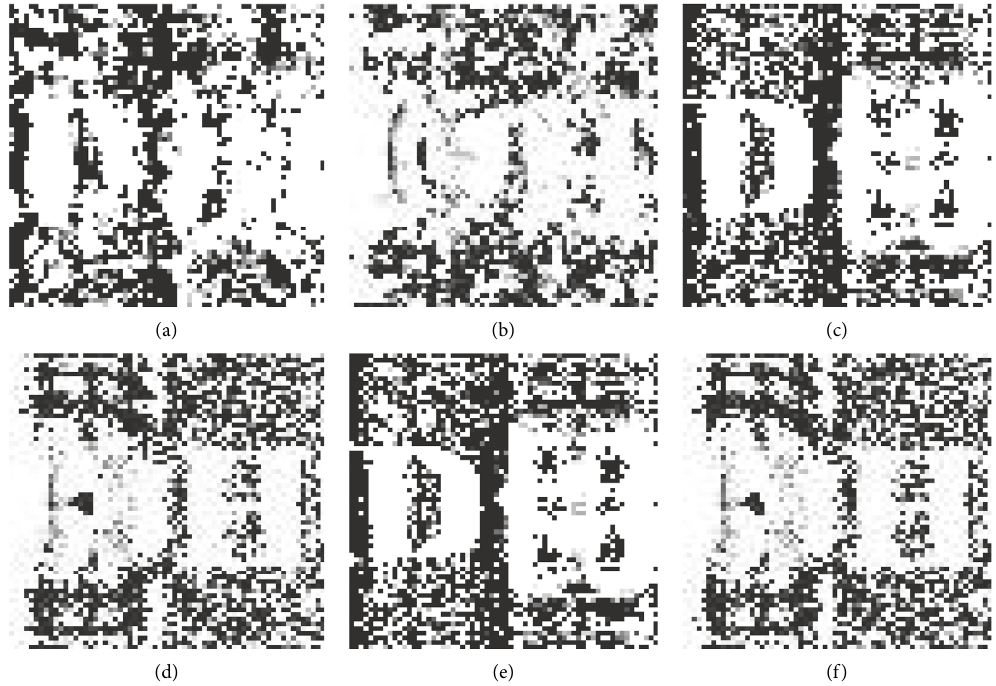
Figure 11: Phase distribution of the decrypted 3D object using correct keys: (a) reconstructed at first plane with 64 × 64 × 8% measurements; (b) reconstructed at second plane with 64 × 64 × 8% measurements; (c) reconstructed at first plane with 64 × 64 × 25% measurements; (d) reconstructed at second plane with 64 × 64 × 25% measurements; (e) reconstructed at first plane with 64 × 64 × 65% measurements; (f) reconstructed at second plane with 64 × 64 × 65%